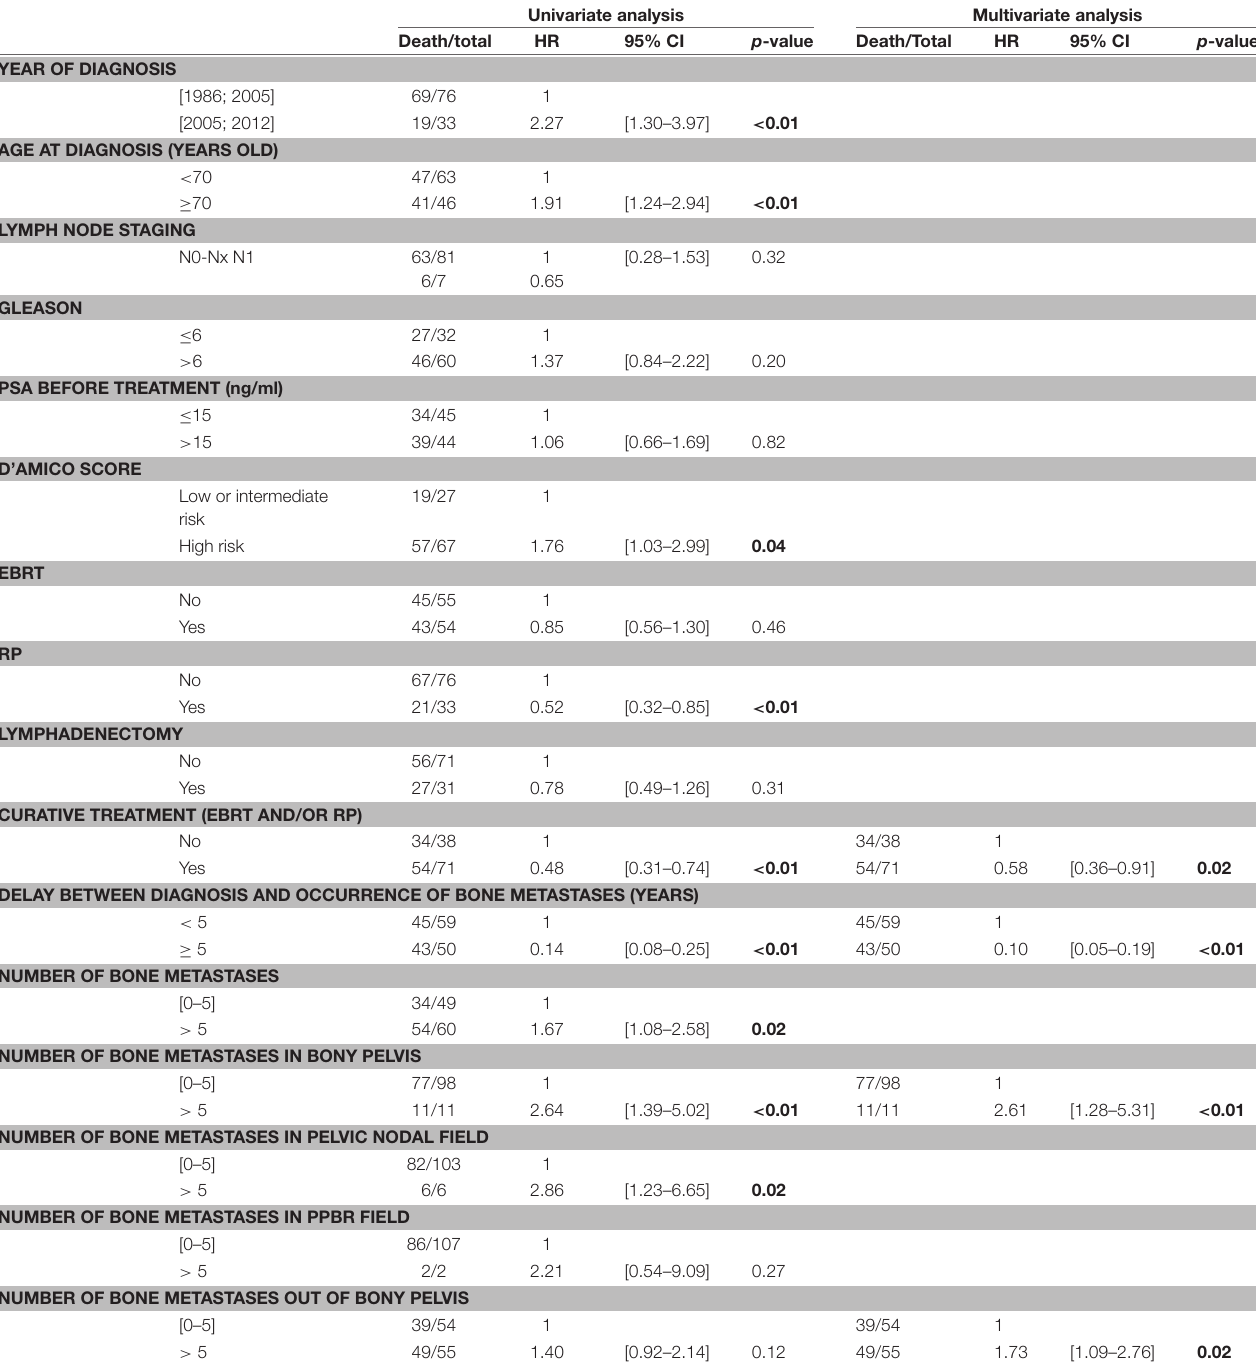
TABLE 4 | Univariate and multivariate analysis of the factors associated with overall survival (Cox